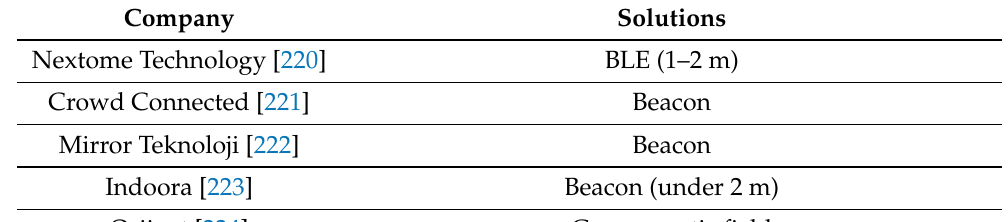
Table 8. Commercial applications based on magnetic positioning of